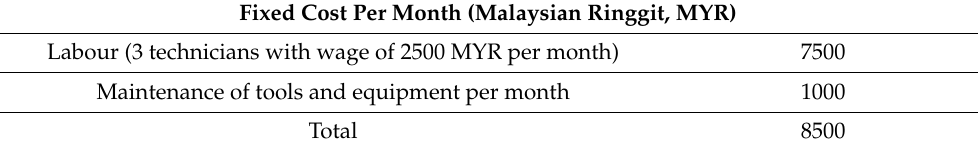
Table 18. Fixed cost per month for production (case 1).